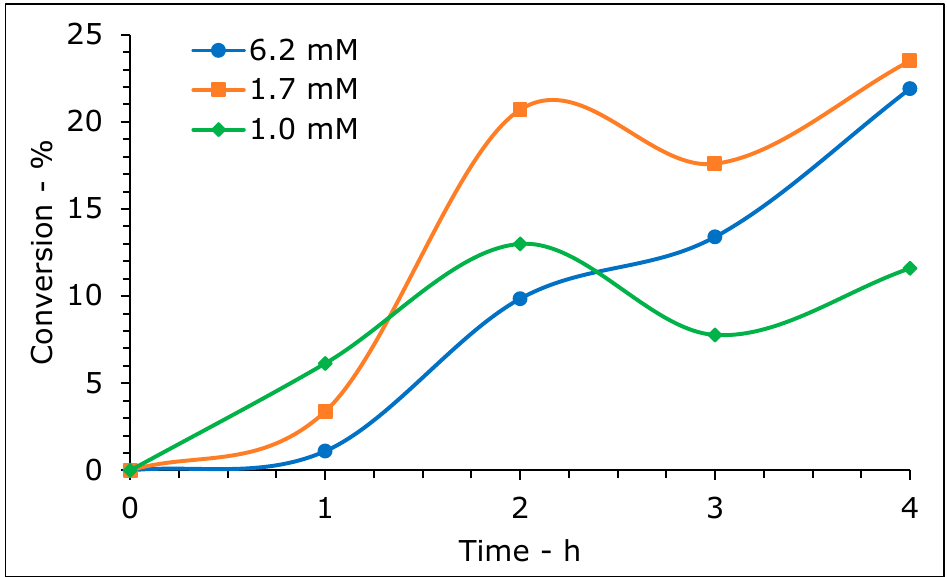
Figure 5. Photo-reduction of NO 3- under LED lamp with 0.1% Ag/FSP as photocatalyst (0.034 mol NO3- /g cat ), various concentration of NaNO 3 (1–6.2 mM), pH 5, rt and 1000 mL of solution (Reactor 2).